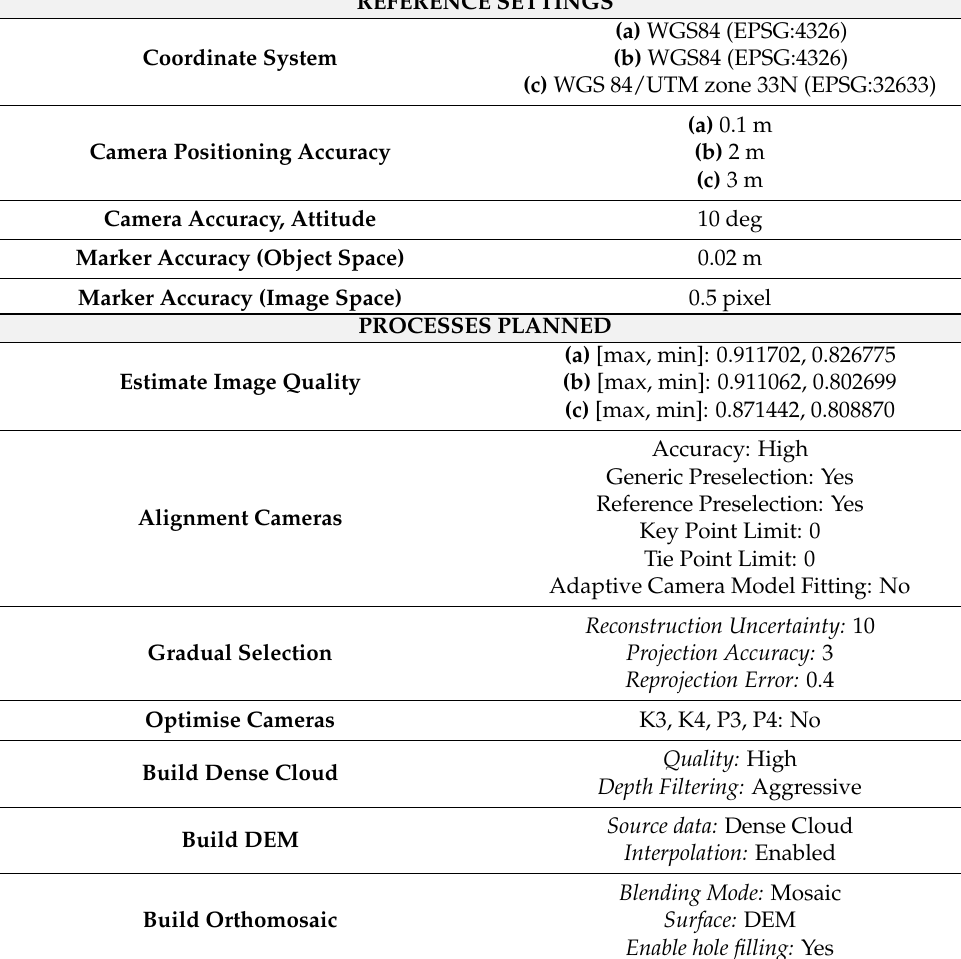
Table 2. Schematisation of settings used in photogrammetric